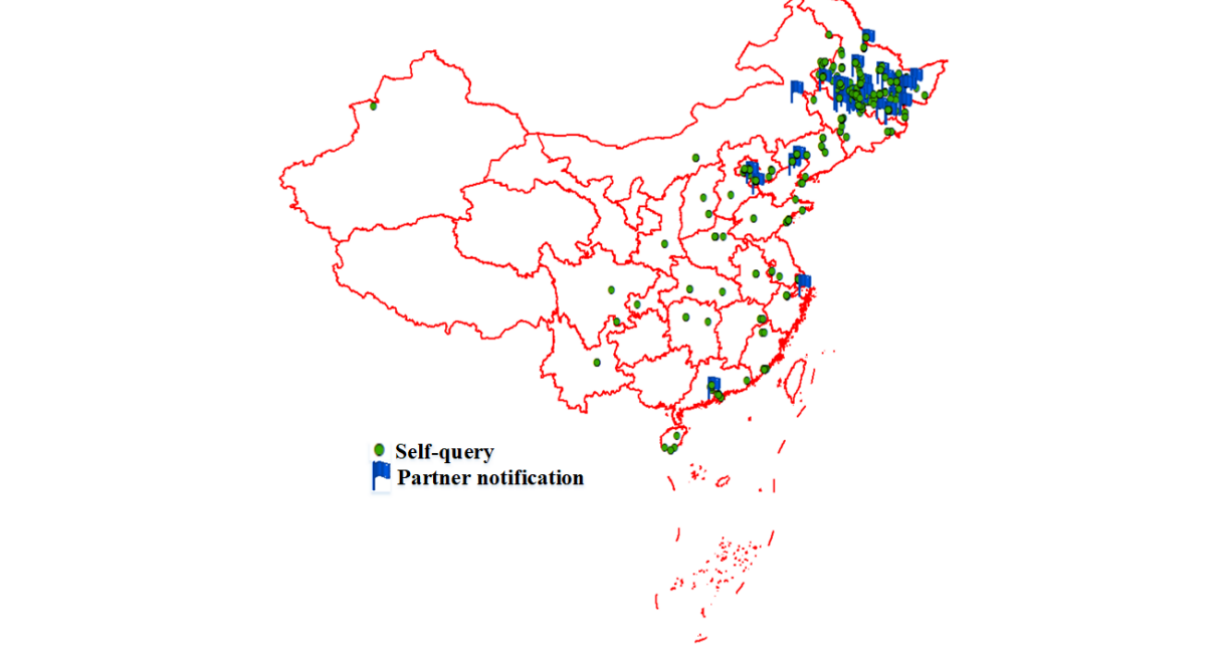
Figure 4. Location distribution of the self-queries and partner